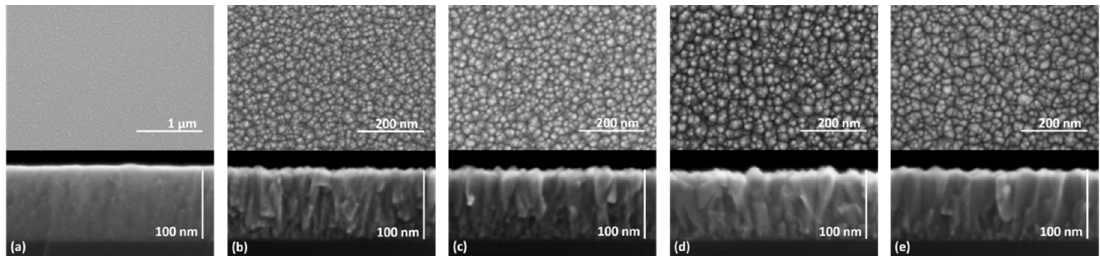
Figure 2. SEM images of analyzed ZnO ozone-based samples: top-view ( top panel ) and cross section ( bottom panel ). The results for samples grown at 50° C ( a ), 100 °C ( b ), 150 °C ( c ), 200 °C ( d ), and 250 °C ( e ) are shown.